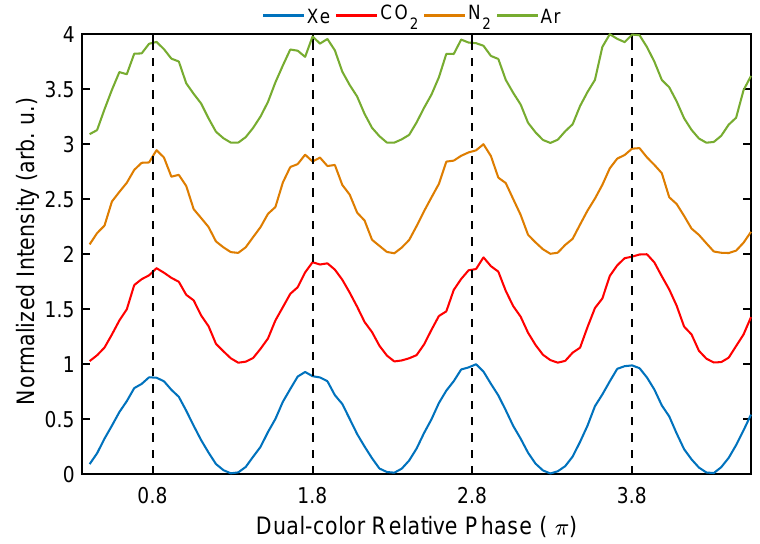
Figure 9. The normalized THz yields as functions of the dual-color relative phase for xenon (blue), carbon dioxide (red), nitrogen (orange) and argon (green) under the same experimental conditions (laser intensity of the ω and 2 ω is about 1.8 × 10 14 W/cm 2 and 1.8 × 10 13 W/cm 2 , respectively). The optimal phases for THz outputs are highlighted by the black dashed lines. Vertical shifts are applied on the baselines of different gas types to offer a more clear